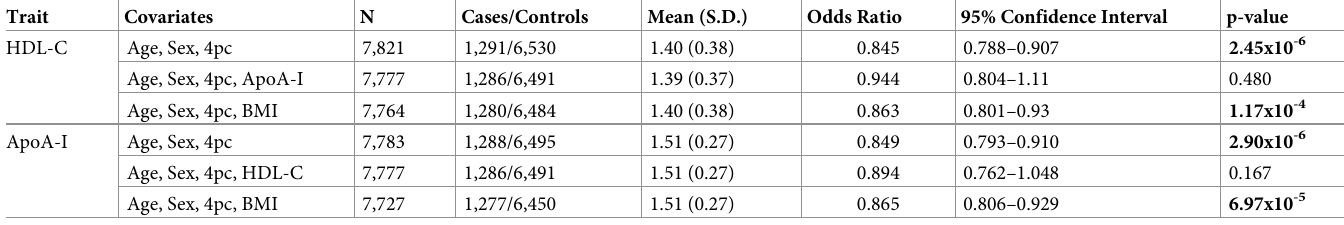
Table 3. Effect of HDL and